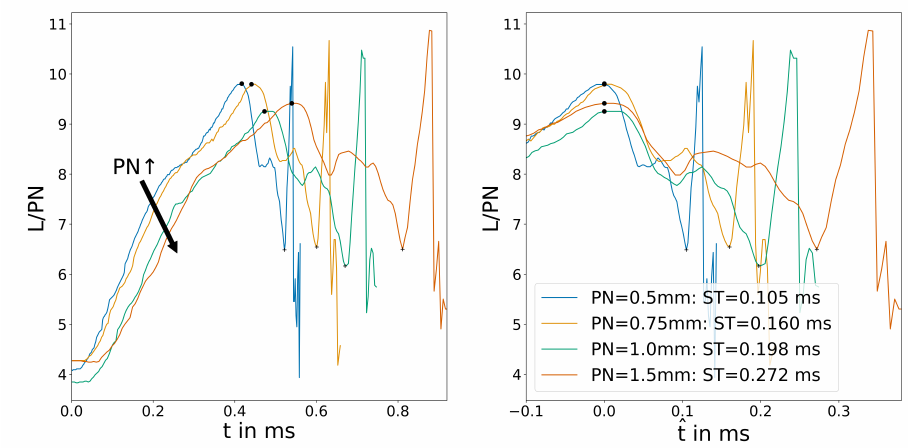
Figure 12. Position of the reattachment point determined by wall shear stress for the variation of PN .